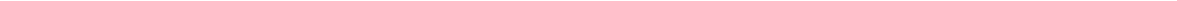
Fig. 3 NLRP11 KD or KO enhances IKK and MAPK signaling. a , b Immunoblot analysis of total and phosphorylated IKK, I κ B α , and MAPKs (p38, JNK, and ERK) in THP-1 cells a or PBMCs b transfected with the indicated siRNA and stimulated with LPS for indicated periods. c , d Sequence c and immunoblot analysis d of cell extracts from WT and NLRP11 knockout (KO) THP-1 cells with the indicated antibodies. e WT or NLRP11 KO THP-1 cells were stimulated with LPS for indicated periods, and then WCLs were subjected to immunoblot analyzes with the indicated antibodies. f WT or NLRP11 KO THP-1 cells were stimulated with Pam3CSK4 (100 ng/ml), poly(I:C) (10 μ g/ml), LPS (100 ng/ml), or CL097 (1 μ g/ml) for 24 h before the supernatants were collected. The production of TNF and IL-6 was measured by ELISA. g WT and NLRP11 KO THP-1 cells were infected with HKST with indicated time, and the whole-cell lysates were subjected to immunoblot analyzes with indicated antibodies. h WT or NLRP11 KO THP-1 cells were exposed to HKST for 24 h and the production of TNF and IL-6 was measured by ELISA. Experimental data a , b , d , e , g are representatives of three experiments with similar results. Data f , h are presented as mean ± SEM of combined from three individual experiments with triplicate. * P < 0.05, ** P < 0.01, and *** P < 0.001 compared to